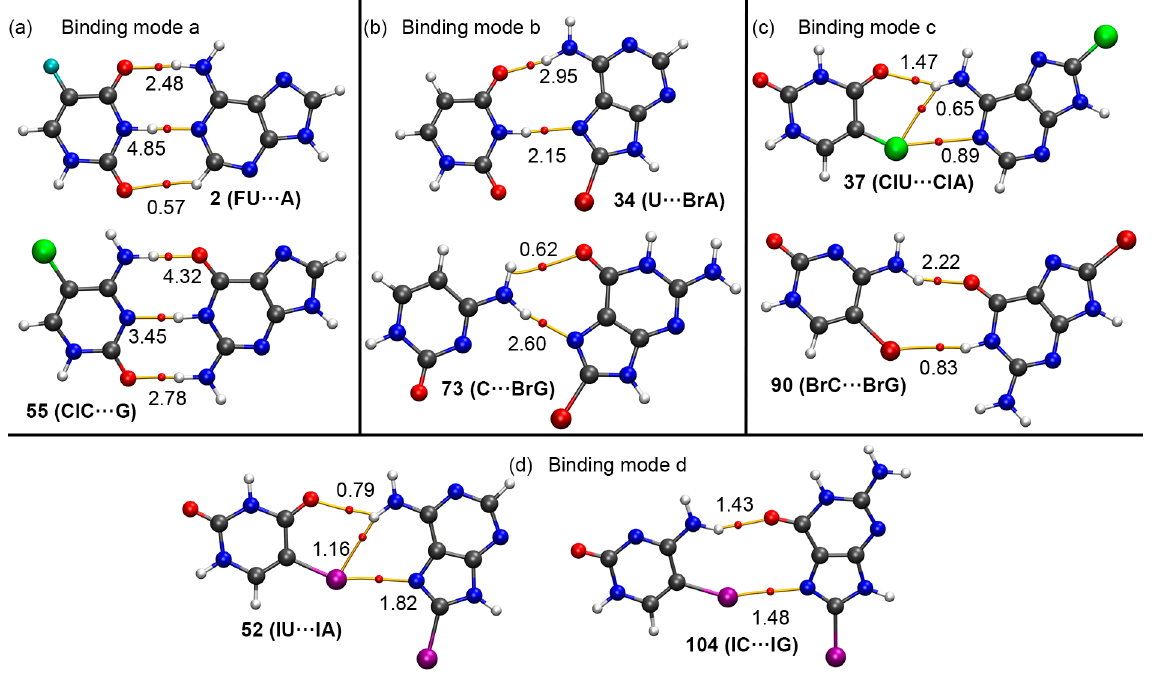
Figure 7. Distribution of critical points and bond paths in several halogenated BPs. Only the intermolecular bond critical points (BCPs) involving hydrogen bonding and/or halogen bonding interactions are shown, denoted by red dots. The bond paths connecting bond critical points are also represented. The value of the density at the BCPs characterizing the HBs and HalBs ( ρ ·10 2 , a.u.) is also indicated in a.u.